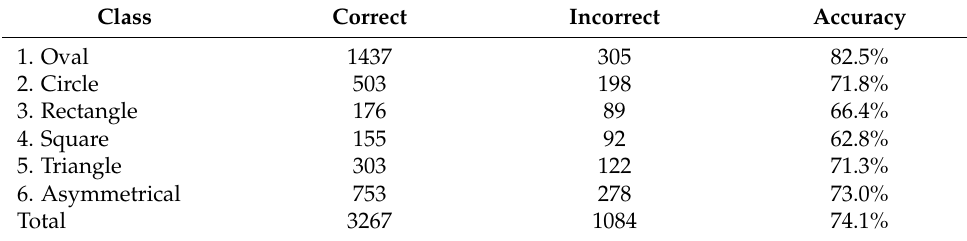
Table 2. Classification by form using the centroid distance function (CDF) approach.